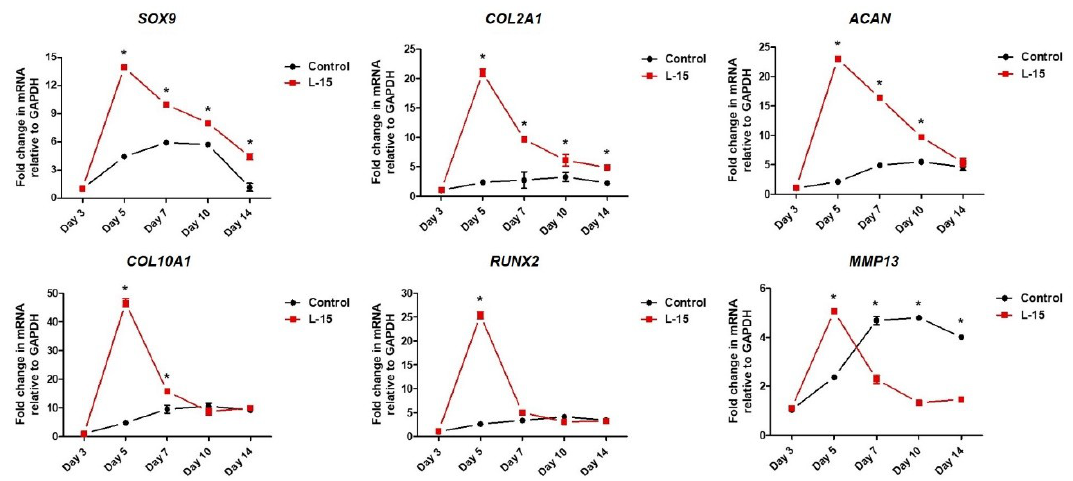
Figure 3. Total RNA was prepared from culture days 3, 5, 7, 10, and 14. The expression of early-stage chondrogenic marker genes ( SOX9 , COL2A1 , and ACAN ) and late-stage chondrogenic marker genes ( COL10A1 , RUNX2 , and MMP13 ) was analyzed by qRT-PCR. GAPDH was used for normalization ( n = 3). Error bars represent mean ± S.D. * p < 0.05 , two-way ANOVA was used.